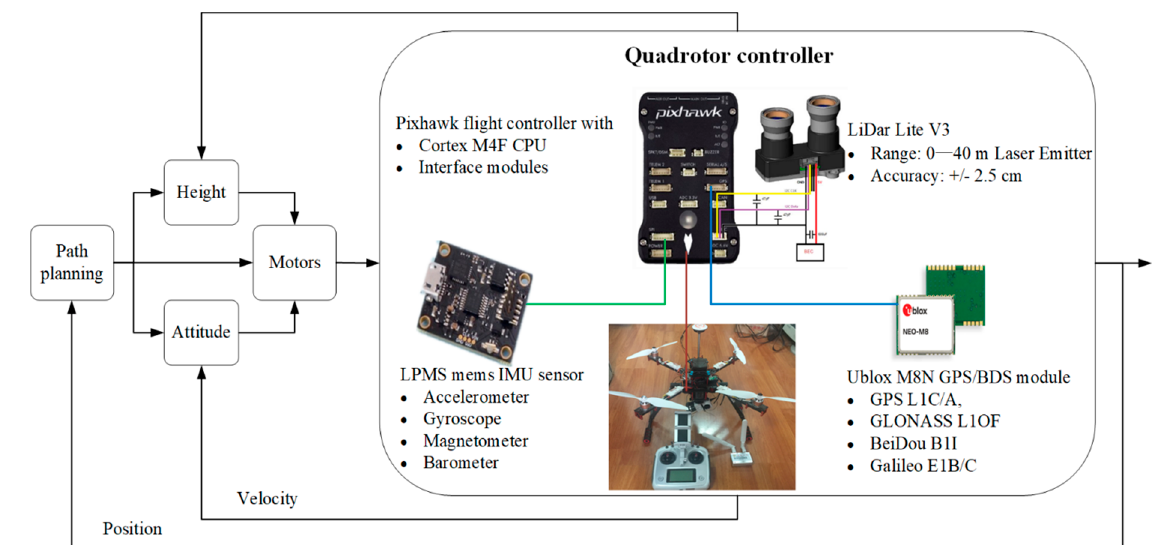
Figure 1. Multi-sensor based position, attitude and height control loops for terrain-following of the autonomous quadrotor.